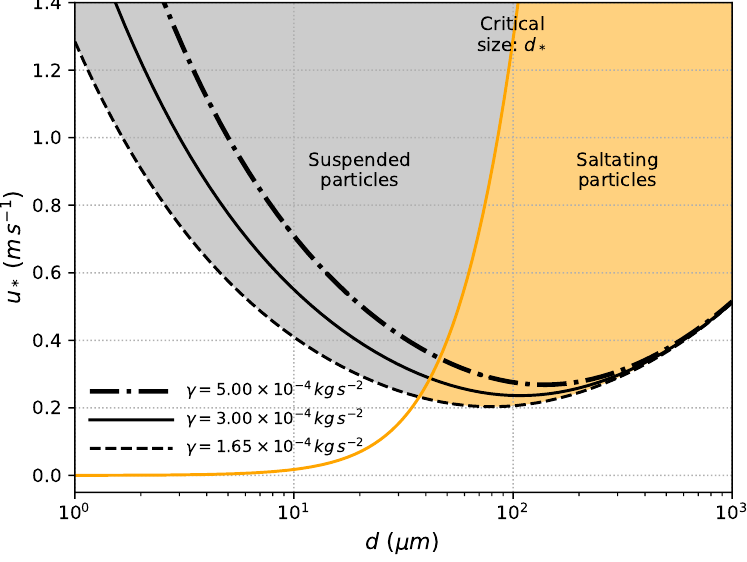
Figure 4. Two-dimensional diagram in the u ∗ – d space (i.e., friction velocity and particle size) showing the conditions required to initiate suspension and saltation of particles from a state of repose. Curves of static threshold friction velocity for spherical particles loosely spread over a dry and bare surface are computed according to Shao and Lu [53] model (black lines). For illustrative purposes, typical values of the experimental parameter γ , accounting for the effect of inter-particle cohesion, are considered. In this work, γ = 1.65 × 10 − 4 is assumed. The critical particle size, d ∗ , is used in this work to define the transition, established via the condition given by Equation (9), between the saltation and suspension types of particle